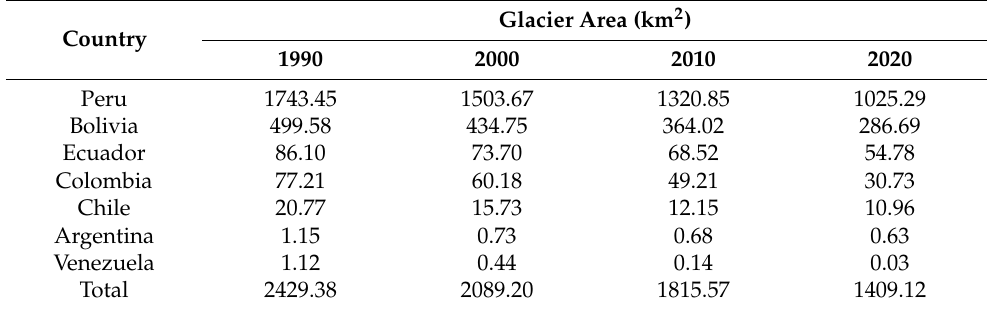
Table 2. Glacier-mapping summary statistics estimated for decennial periods per